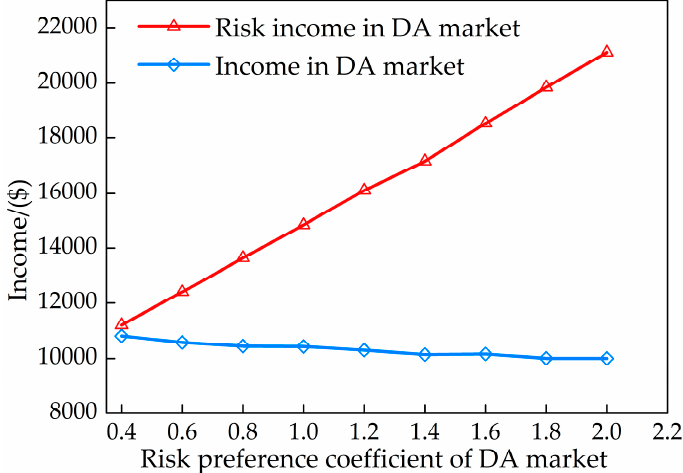
Figure 11. Risk income and actual income under different risk preference coefficients of the DA